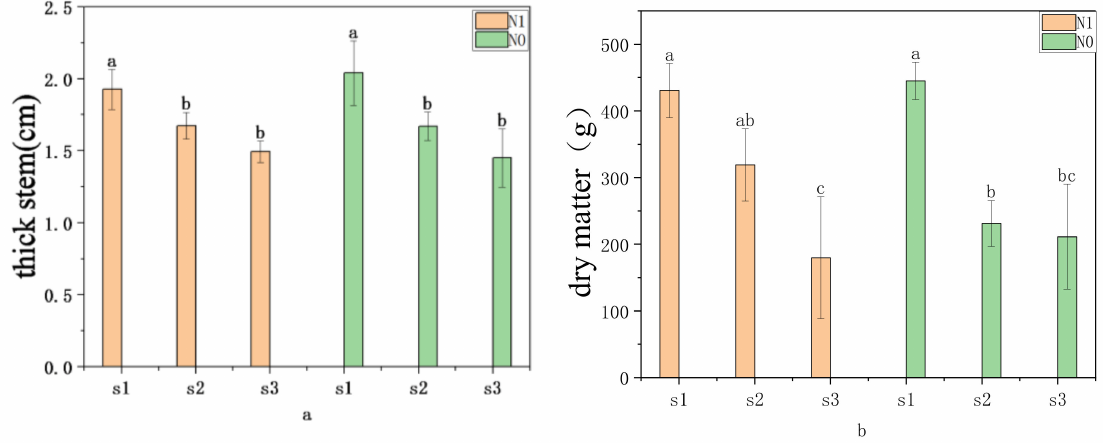
Figure 3. Effects of different nitrogen (N) and salt (S) treatments on stem diameter at the stage of V12 ( a ) and dry matter at the maturity stage ( b ). Different letters indicate statistically significant ( p < 0.05) differences between the treatments using a Tukey post hoc test. N1 is nitrogen application, and N0 is no nitrogen application. S1, S2 and S3 are the soil salinity concentrations of 0%, 0.1% and 0.25%,